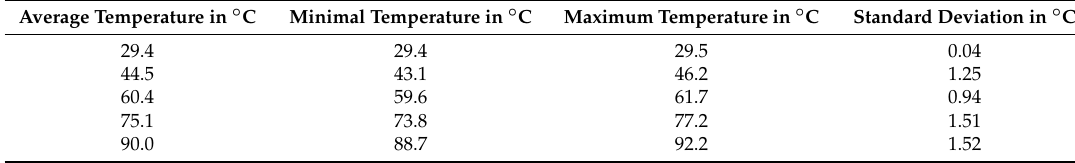
Table 2. Temperature distribution in piston-cylinder set-up.